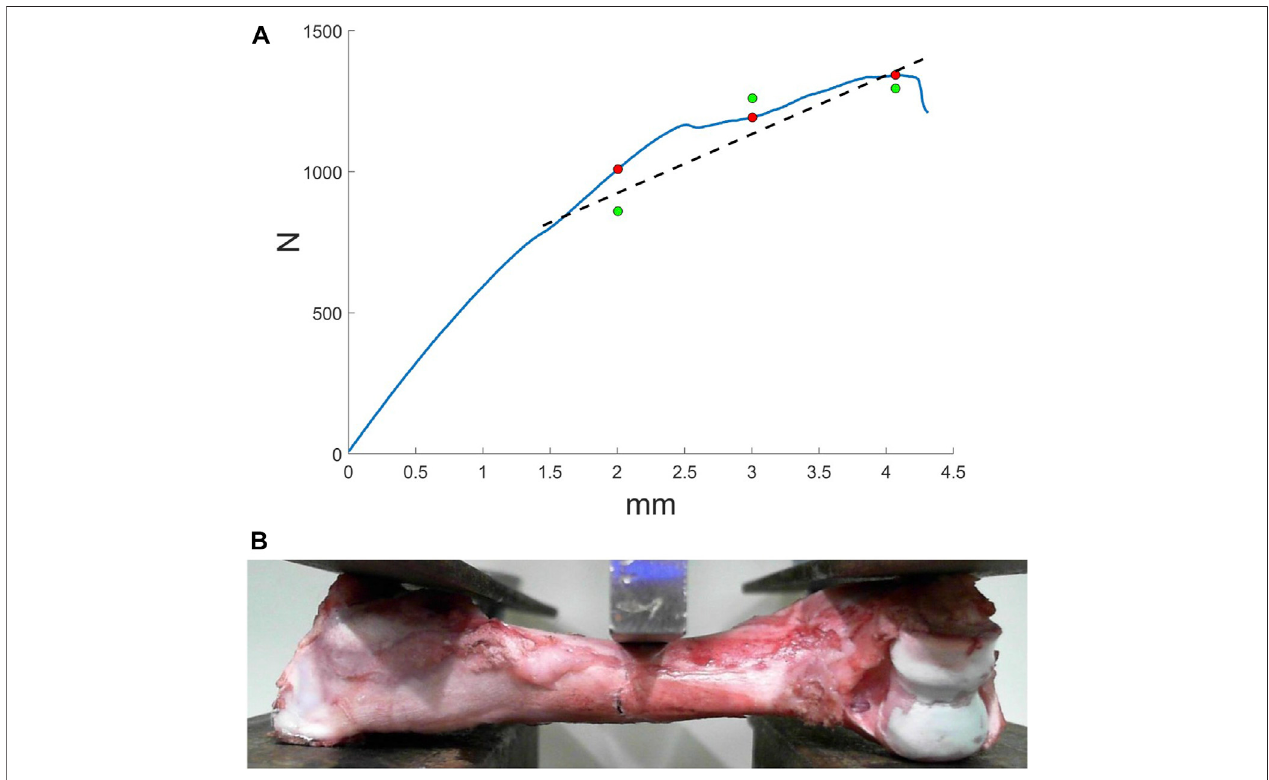
FIGURE 4 | Results of three-point bending experiments: (A) force-displacement curve, where green markers indicate the equivalent force from the simulation, red markers correspond to the force form the experiment, dashed line — approximation of the equivalent force: (B) bone fracture formation.